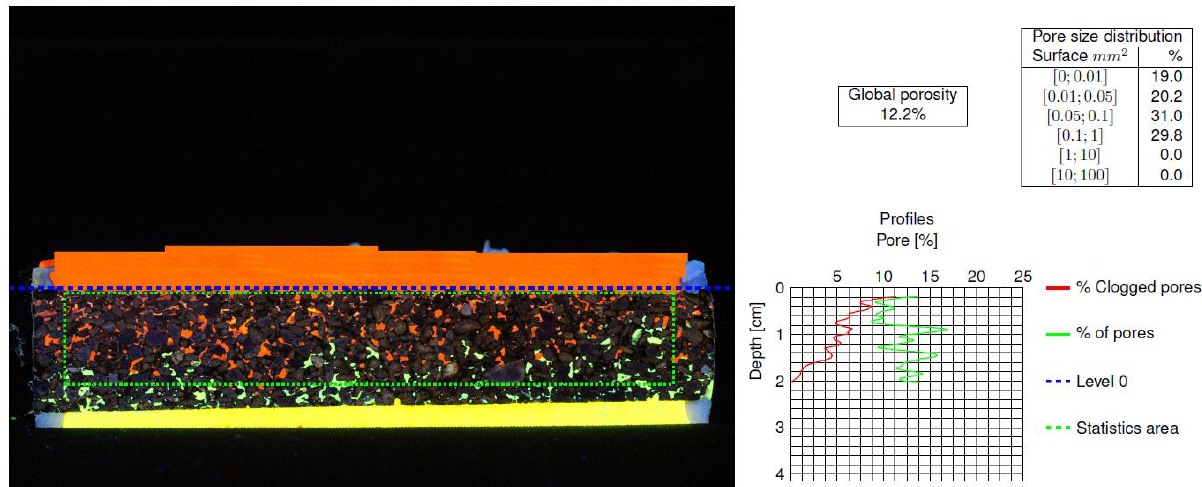
Figure 10: Example of an automatic image analysis with indication of the total porosity, the pore size distribution and the profile of total and clogged porosity as a function of depth (the core diameter is 150